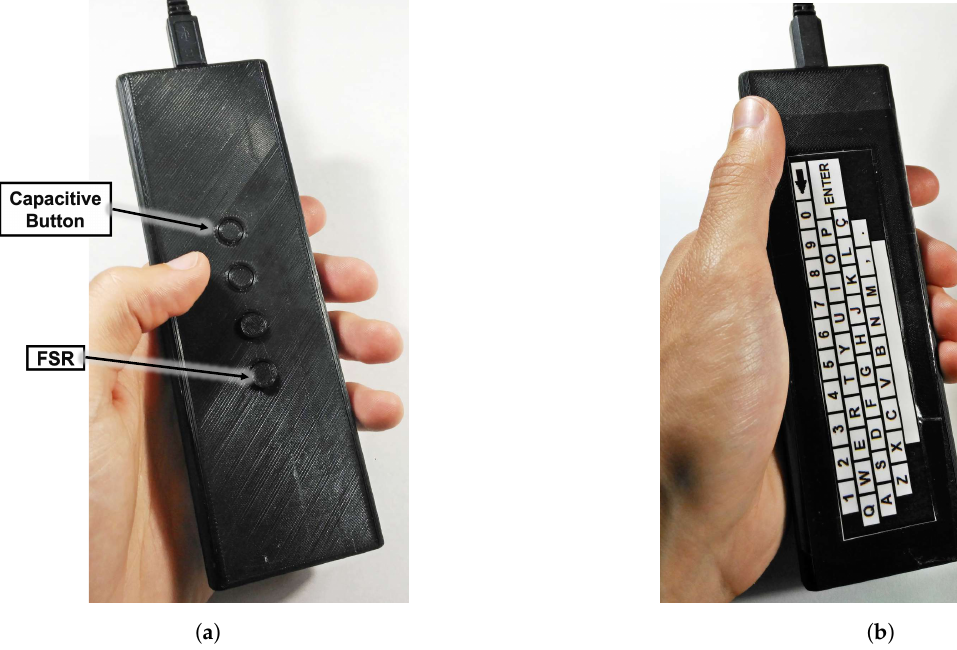
Figure 2. Evaluation prototype-3D printed structure; ( a ) Top outer part; ( b ) Bottom outer part.